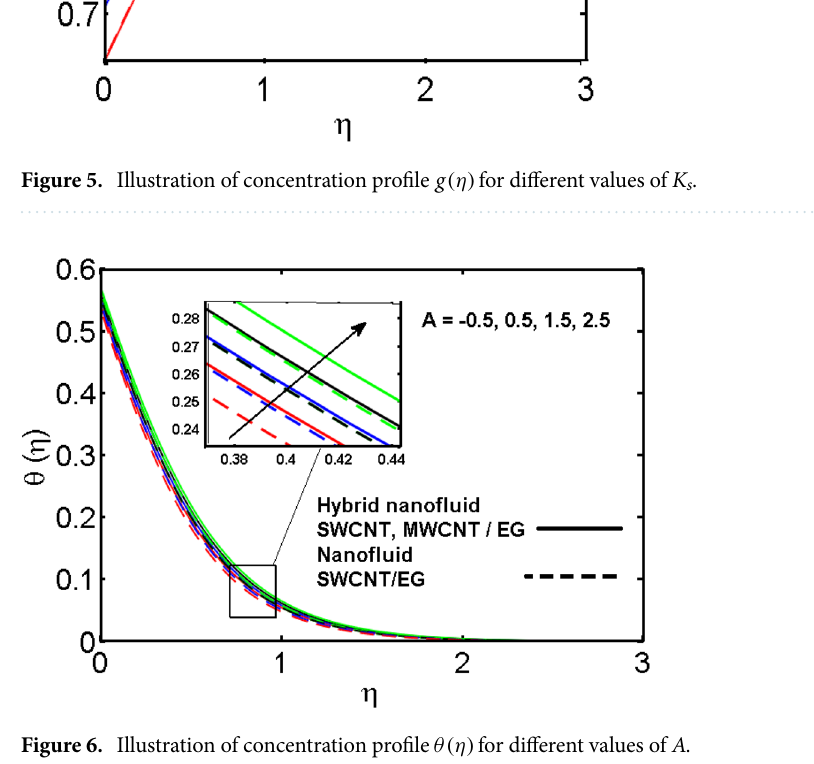
Figure 6. Illustration of concentration profile θ(η) for different values of A .